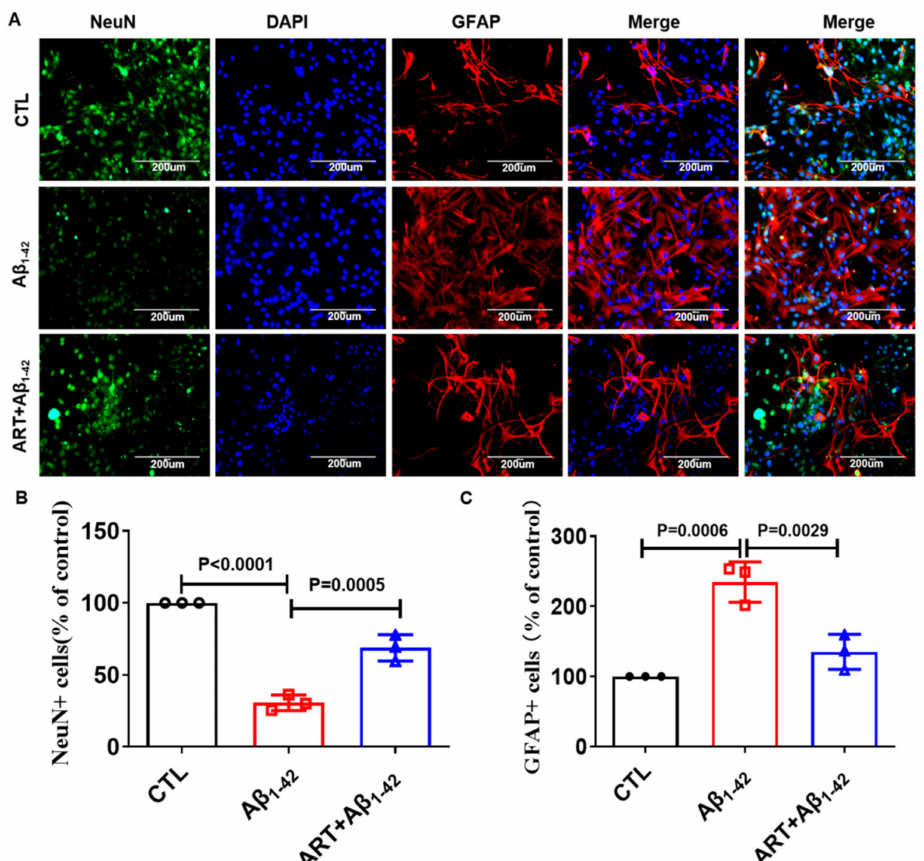
Figure 5. Artemisinin reduced the excessive activation of astrocytes in Primary cultured neuronal cells. ( A ) IF of NeuN and GFAP in primary cultured neuronal cells. ( B ) Quantitation of NeuN+ cells in A. ( C ) Quantitation of GFAP+ cells in A. p < 0.05 was considered significantly